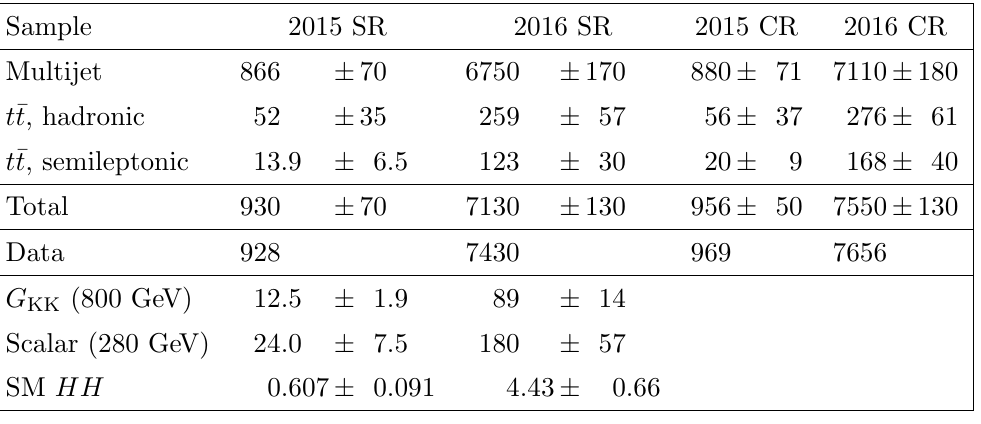
Table 3. The number of predicted background events in the signal region (SR) for the resolved analysis compared to the data, for the 2015 and 2016 datasets. The yields for three potential signals, an 800 GeV G KK resonance with k=M Pl = 1, a scalar with a mass of 280 GeV, and SM non-resonant Higgs boson pair production, are also shown. The scalar sample is normalized to a cross section times branching ratio of 2.7 pb. The quoted uncertainties include both the statistical and systematic uncertainties, and the total uncertainty considers correlations. The numbers of observed and predicted events are also given in the control region (CR).